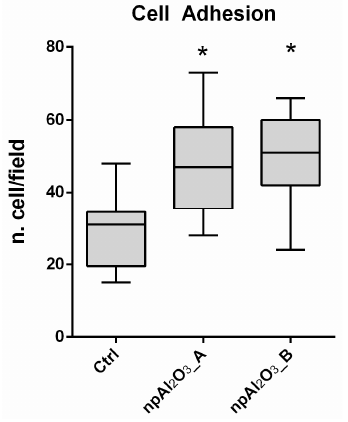
Figure 3. Cell adhesion evaluation. MC3T3-E1 adhesion was evaluated on all samples 10 min after seeding. The level of cell adhesion was measured by counting the number of nuclei for each field. The symbol (*) indicates a statistically significant difference versus the control (Ctrl), considering a p -value < 0.05.